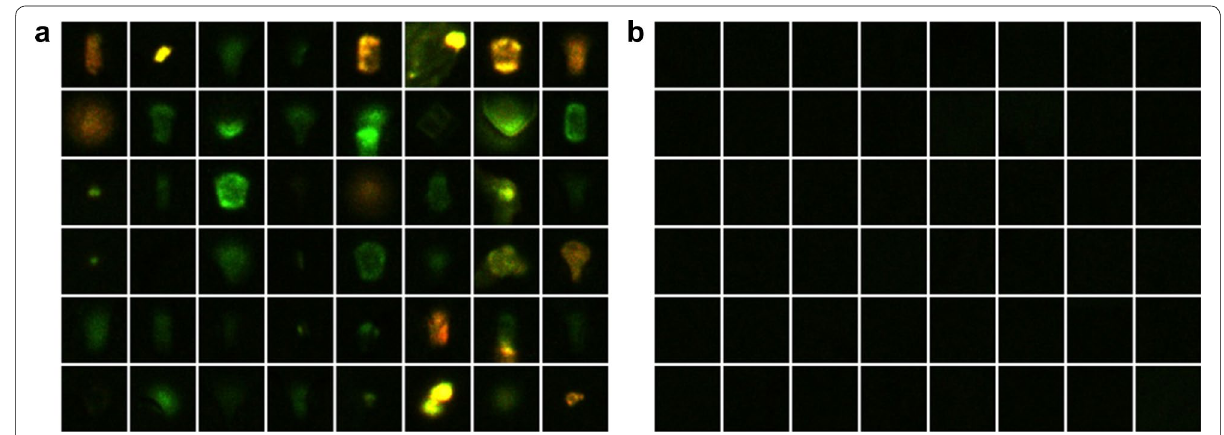
Fig. 4 Dataset that is tailored to be used for the preselection of detection windows. a T-cells, B-cells and noise are all grouped into positive dataset, and b the remaining background images are left as negative dataset